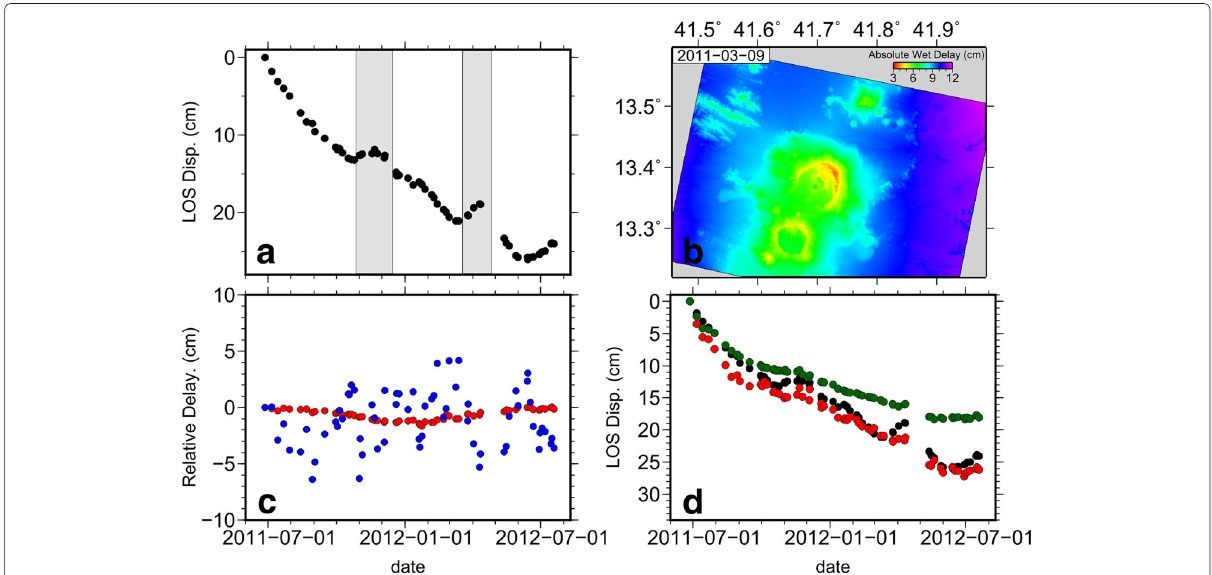
Fig. 4 a Filtered time series of range change (for pixel highlighted in white in Fig. 3c) for the CSK satellite corrected for atmosphere using a standard APS approach (spatio-temporal filtering). Grey bars indicate period of reversed LOS. b Example of observed absolute wet delay across Nabro caldera on a given date. c Time series of wet (blue) and hydrostatic (red) delays of the summit pixel with respect to the reference pixel (black star Fig. 2c), relative to the first day of acquisition. d Time series of range increase corrected using ERA-I data (red), APS spatio-temporal filtering (black) and a linear-with-height relationship